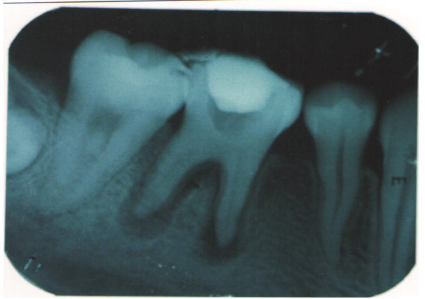
Figure 2: Ca(OH) 2 paste placed (36).